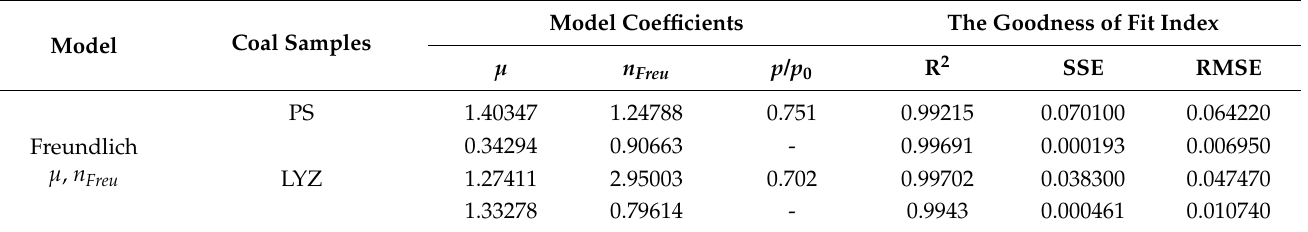
Figure 7. Water vapor adsorption isotherms for PS and LYZ recovered from linear fits of the Freundlich model. Table 3. Freundlich Modeling Parameters of Adsorption Isotherms of PS and LYZ coal samples.